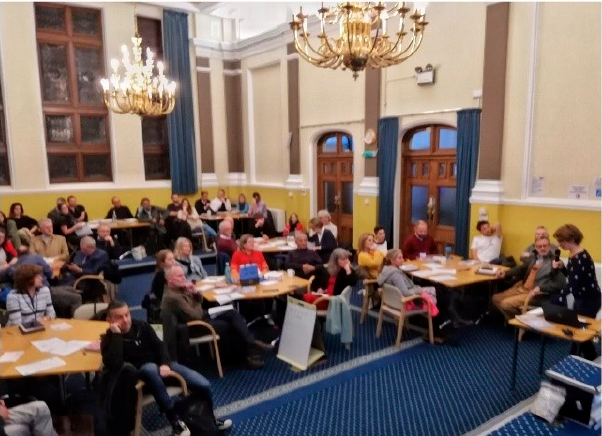
Figure 4. Author on right giving talk at EAN inaugural meeting, 9 November 2019 @Brian Booker.